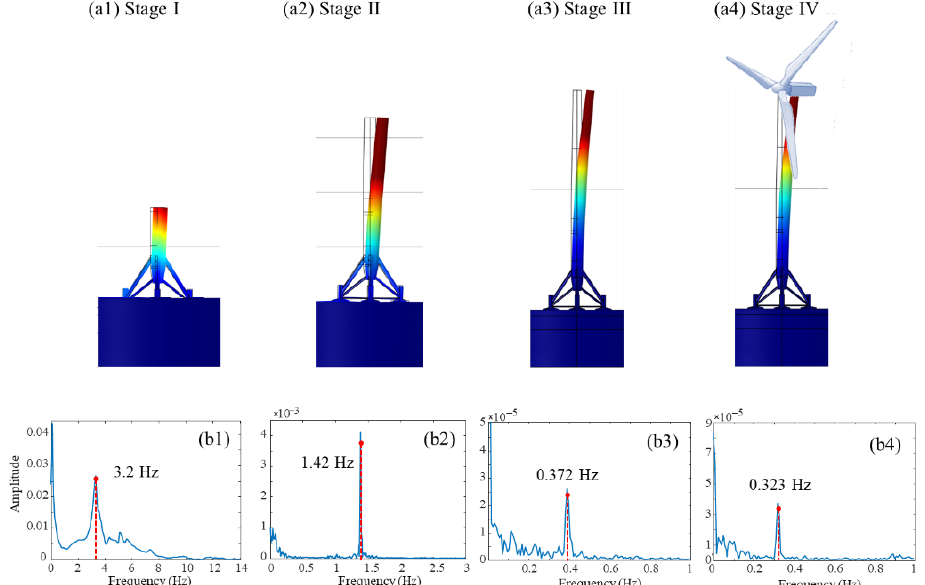
Figure 2. Dynamic response of the OWT for different installation stages. ( a1 – a4 ) First mode shape of the OWT for Stages I–IV; ( b1 – b4 ) Frequency response of the accelerometers for Stages I–IV; the NF of each stage is indicated within the corresponding